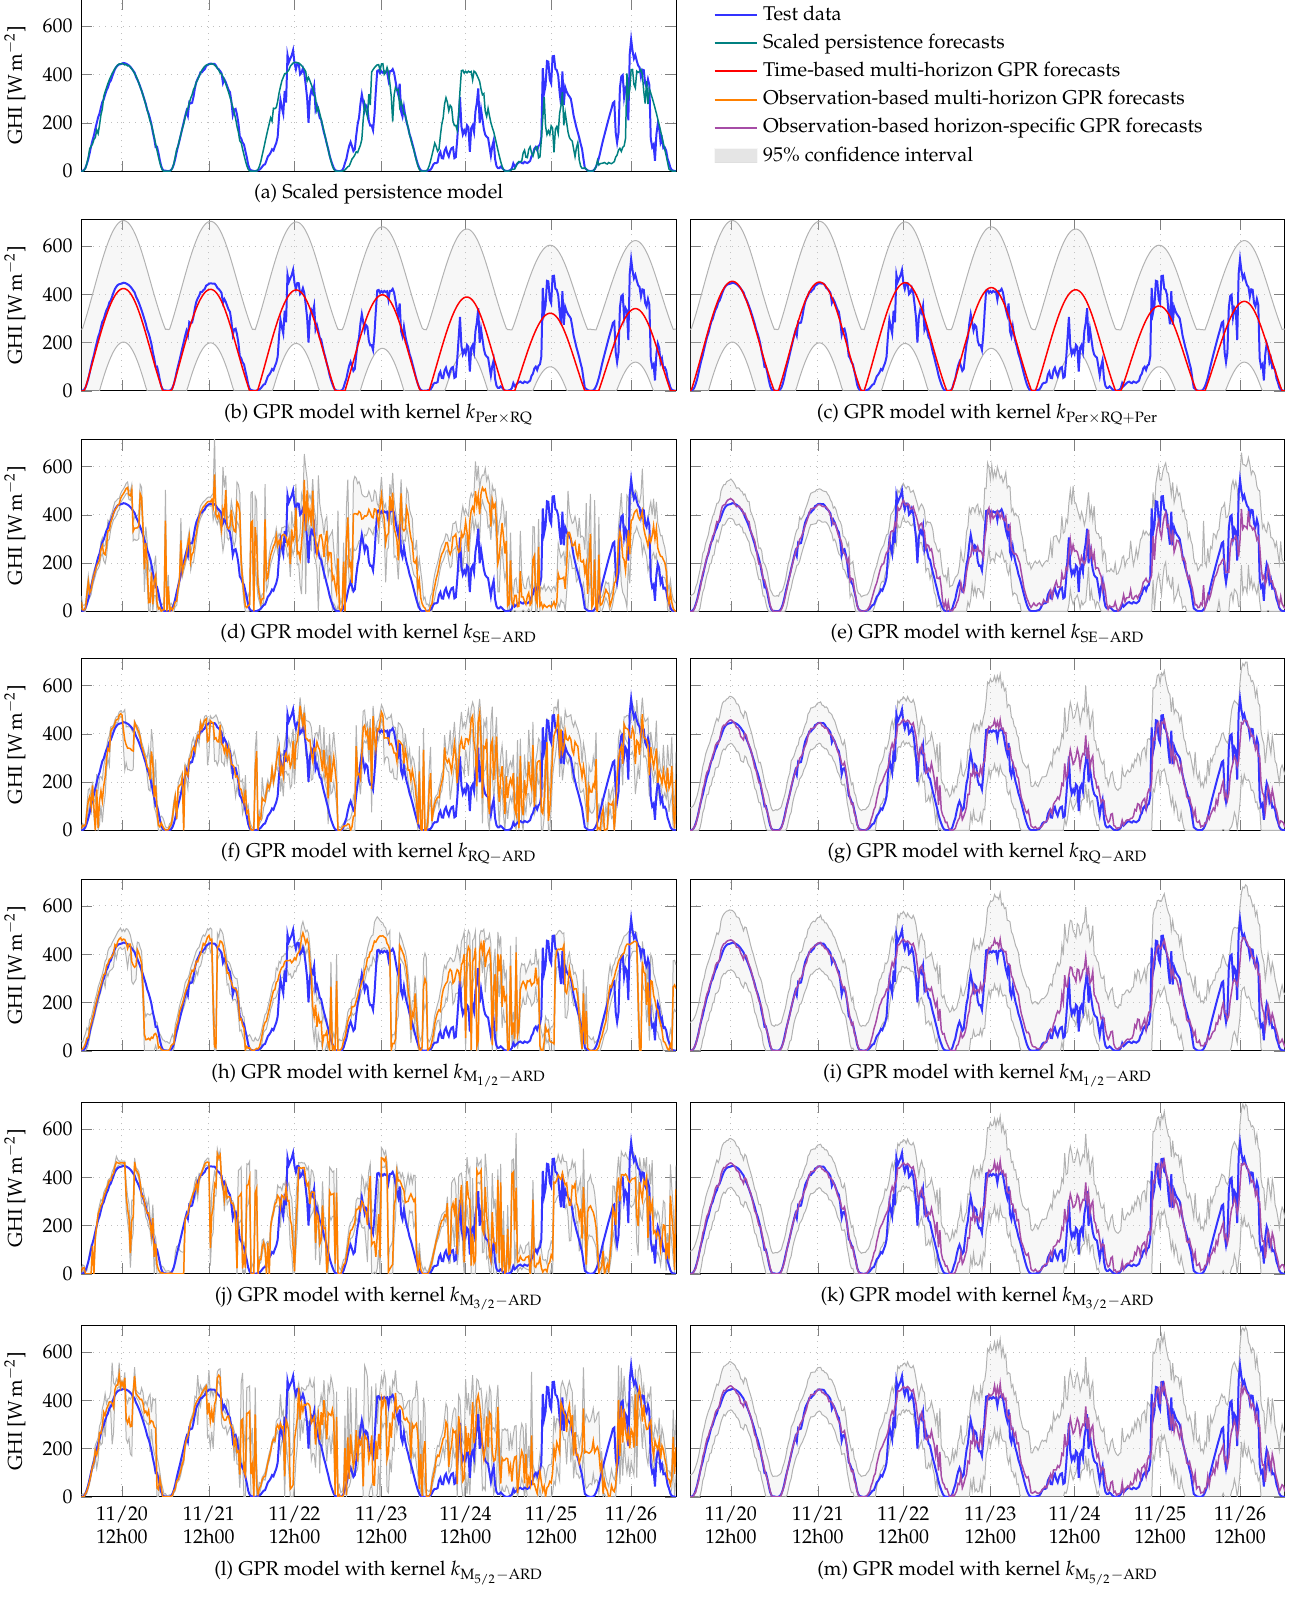
Figure 15. Examples of 24 h GHI forecasts over one week, given by the scaled persistence model and the GPR models included in this